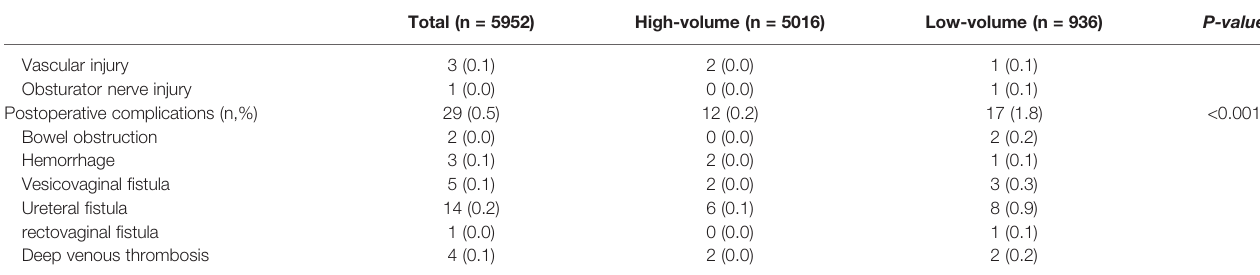
Meier analysis ( Figure 2 ). The 2-year RFS of patients with T1b1N0 was 97.3%, and the 5-year RFS rate was 96.2% in the 2009 FIGO staging system. While in the 2018 FIGO staging system, the 2-year RFS of patients with stage IB1and IB2 was 97.6%, and the 5-year RFS rate was 96.7%. The recurrence rate was signi fi cantly reduced after 2018 ( P =0.002). Compared